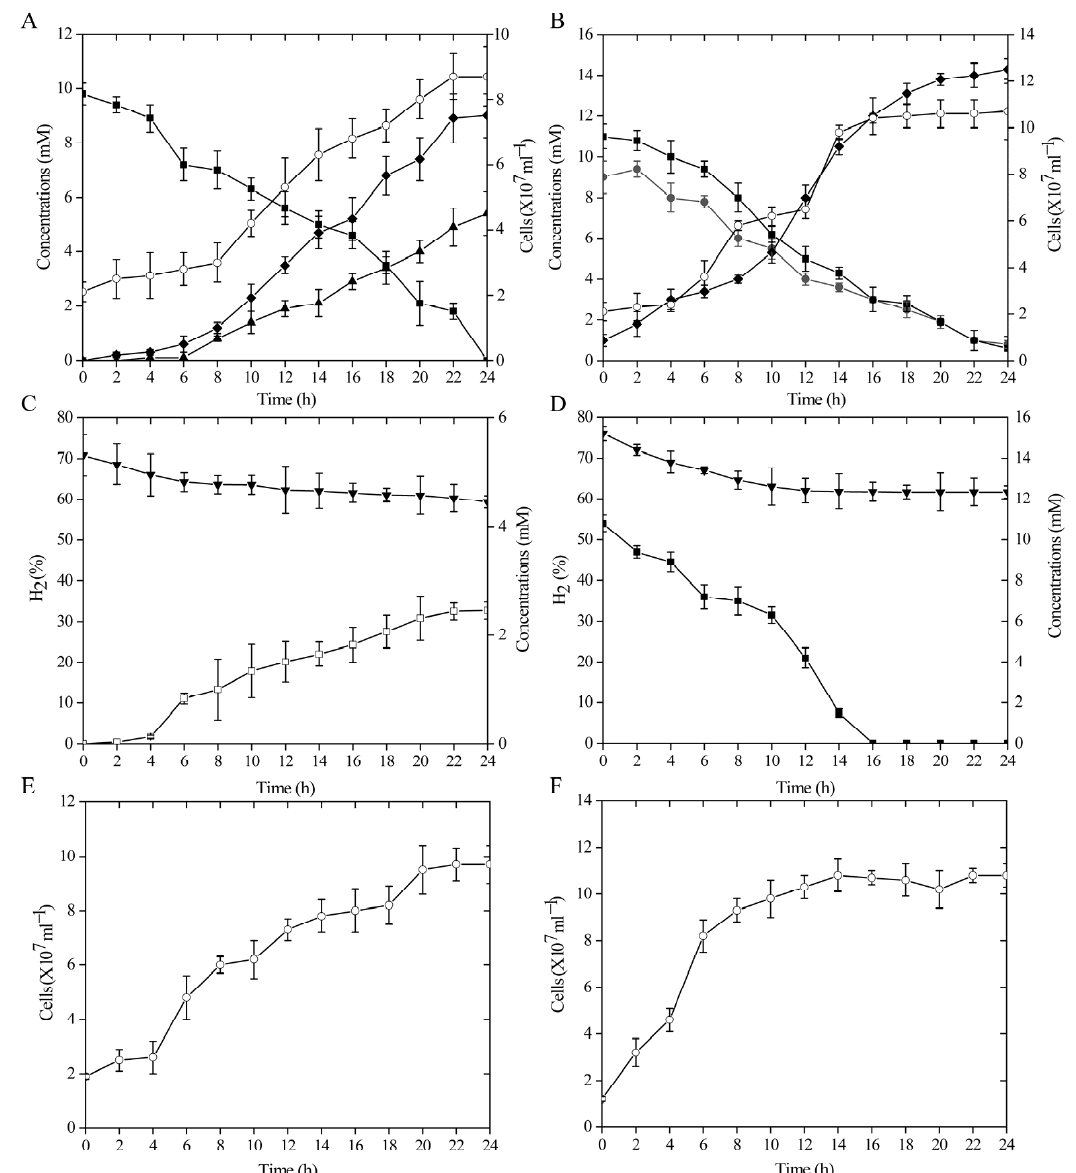
Figure 1. Chemolithoautotrophic growth of S. indicum ST-419 in the presence of S 0 as the sole electron donor ( A ) or the sole electron acceptor ( C ). Cultures of strain ST-419 by thiosulfate oxidation ( B ) and nitrate reduction ( D ) served as controls, respectively. Cell density in S 0 reduction and nitrate reduction is shown in ( E , F ). Error bars indicate the standard deviation between triplicate cultures. Closed squares, diamonds, circles, triangles and inverted triangles indicate the concentrations of NO 3– , SO 42 − , S 2 O 32 − , N 2 and H 2 . Open squares and circles indicate H 2 S concentration and cell numbers, respectively.